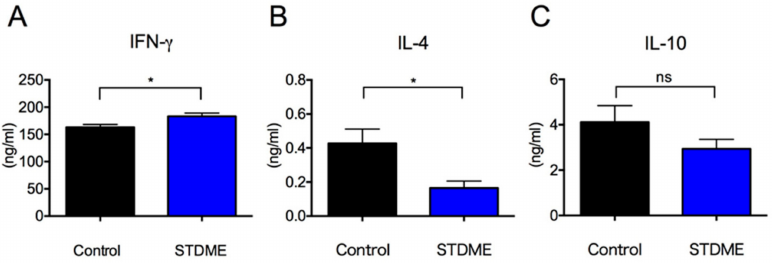
Figure 5. Cytokine production by splenocytes in STDME-fed mice after AOM/DSS-induced CAC. Splenocytes from control or STDME-fed CAC-induced mice were isolated and stimulated with plate-bound anti-CD3 ε mAb for 48 h. ( A – C ) IFN- γ ( A ); IL-4 ( B ) and IL-10 ( C ) cytokines in culture supernatant were detected by ELISA. All data are presented as mean ± SEM and assed with a two-tailed Student’s t -test. * p < 0.05; ns = not significant; n = 10/group. STDME, selenoneine-containing tuna dark muscle extract.